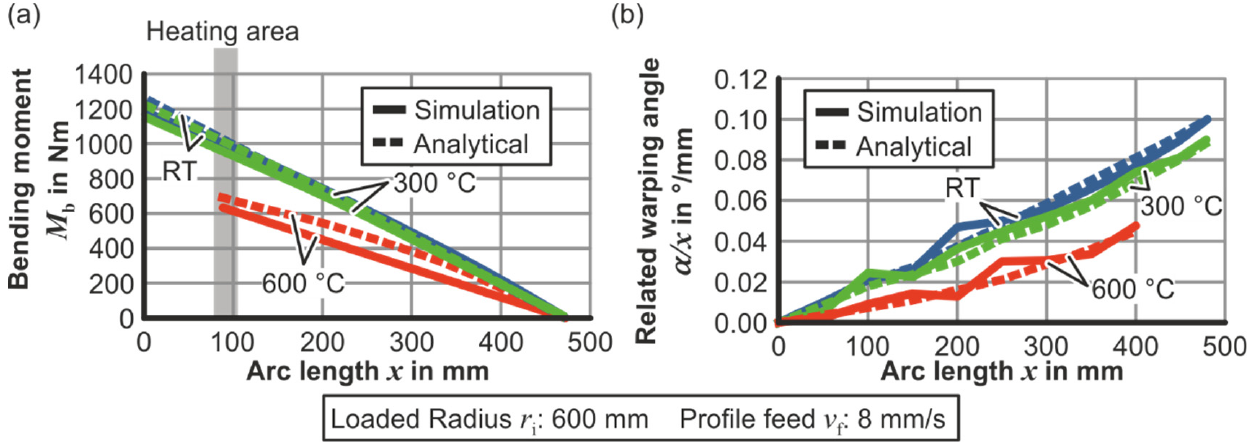
Figure 13. Analytical and numerical bending moment ( a ) and related waring angle ( b ) for the continuous push-bending phase at room temperature, 300 °C and 600 °C for a loaded radius of 600 mm and profile feed of 8 mm/s as a function of profile arc length.